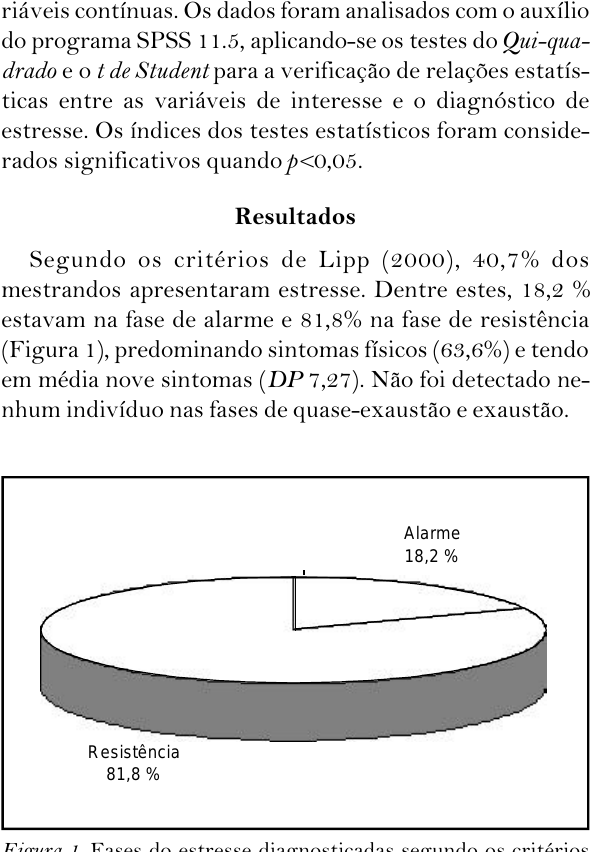
Figura 1. Fases do estresse diagnosticadas segundo os critérios do ISSL ( n